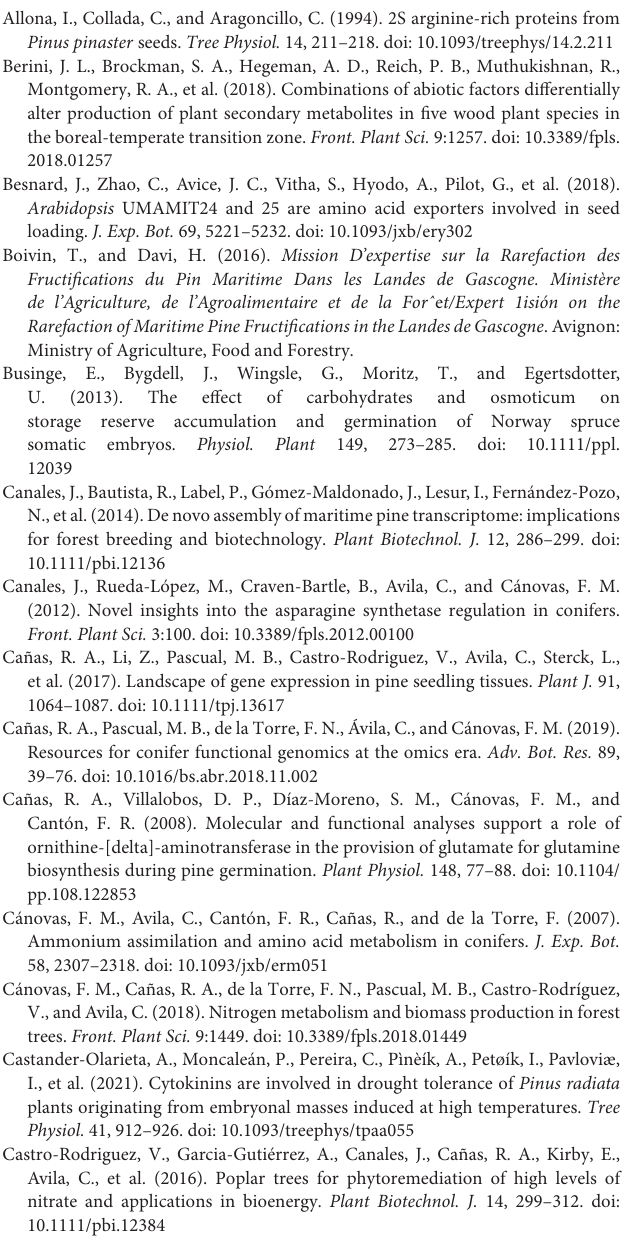
Supplementary Table 2 | List of the primer sequences used for transcript quantitative analysis. Supplementary Table 3 | List of hub genes. Supplementary Table 4 | List of hub TFs. Supplementary File 1 | Gene distribution in co-expression modules. Supplementary File 2 | Distribution of functional categories in gene modules. Supplementary File 3 | Genes differentially expressed in zygotic embryos. Supplementary File 4 | Genes differentially expressed in somatic